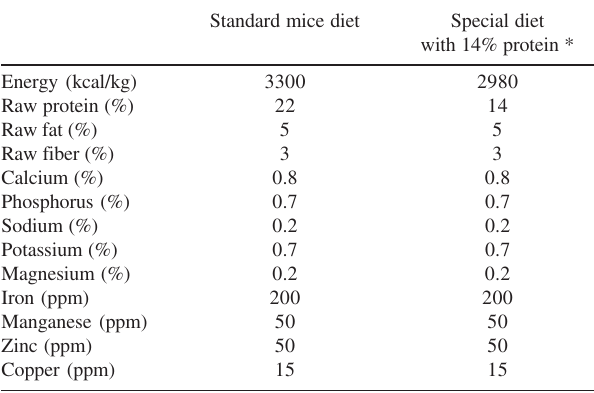
Table 1 - Energy and nutrient content of the diets from both groups Standard mice diet Special diet with 14% protein